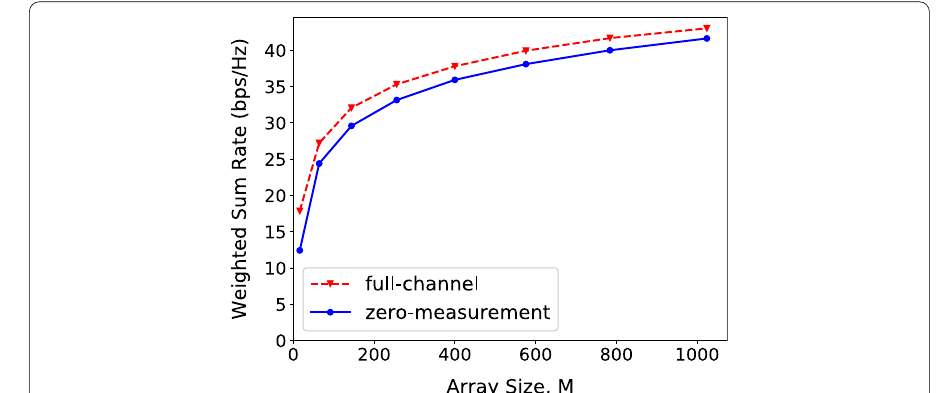
Fig. 9 The weighted sum rate with zero-measurement selection and full-channel selection, respectively. The system setup is that a changing number of antennas base-station select 4 users out of 100 users for downlink beamforming based on simulated channels